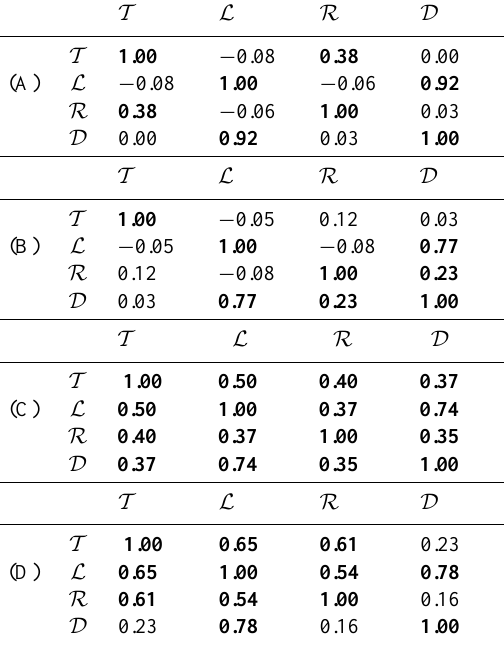
same length are marked in